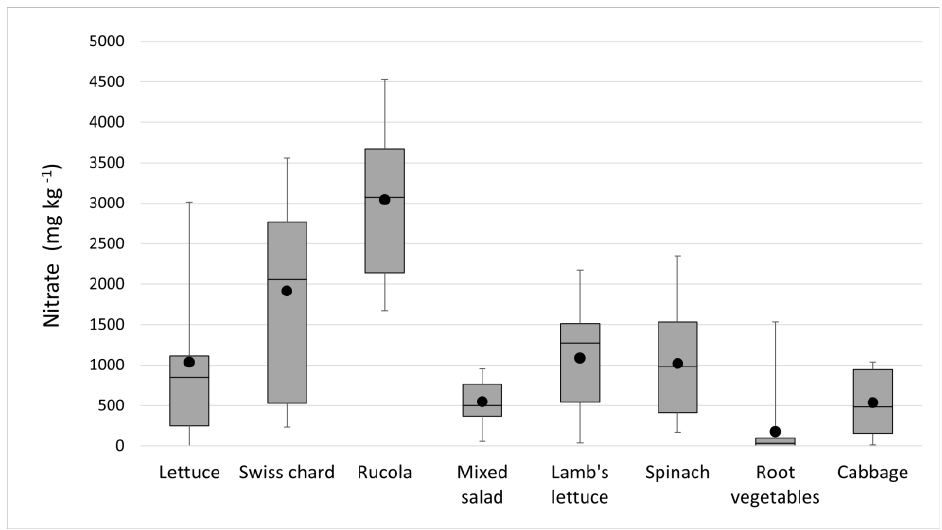
Figure 3. The results of the determination of the nitrate concentrations depending on the variables are shown as the mean value (•); maximum ( ); minimum ( ); and interquartile range (with median ( □ ).